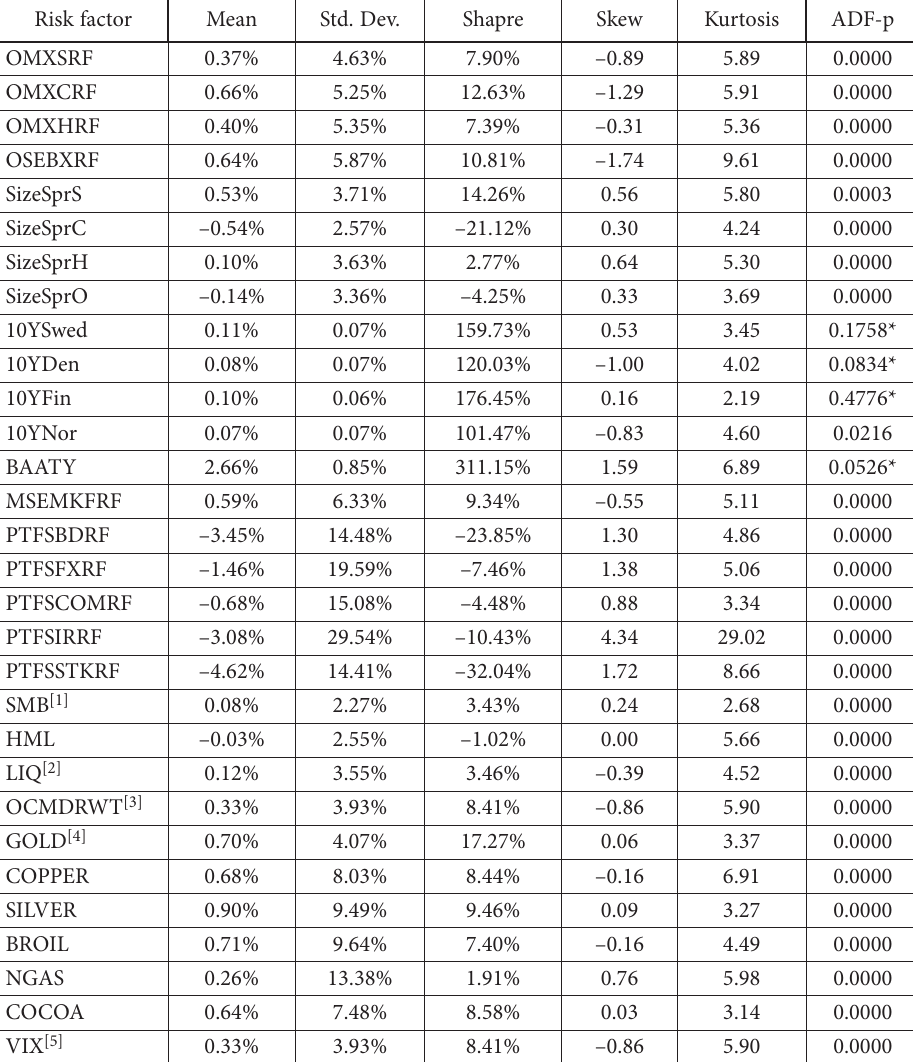
Table 5. Final model risk factors with corresponding summary